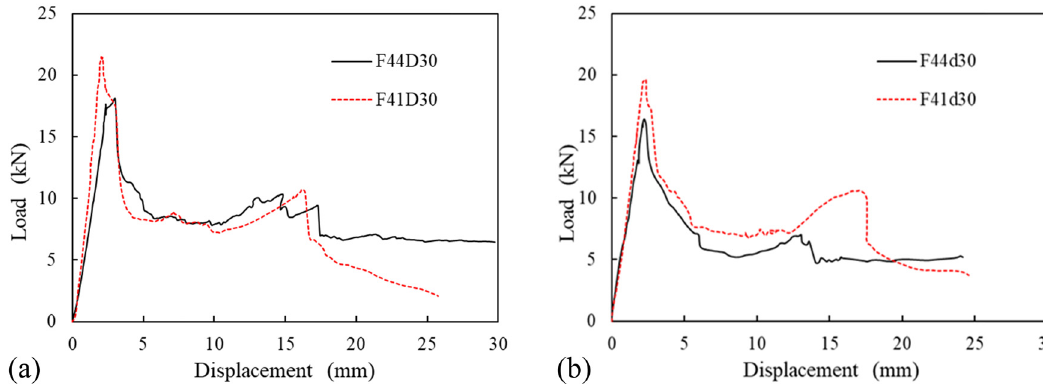
Figure 6: Effect of fiber transverse – longitudinal volume fraction. ( a ) Specimens with foam density 480 kg/m 3 . ( b ) Specimens with foam density 450 kg/m 3 .